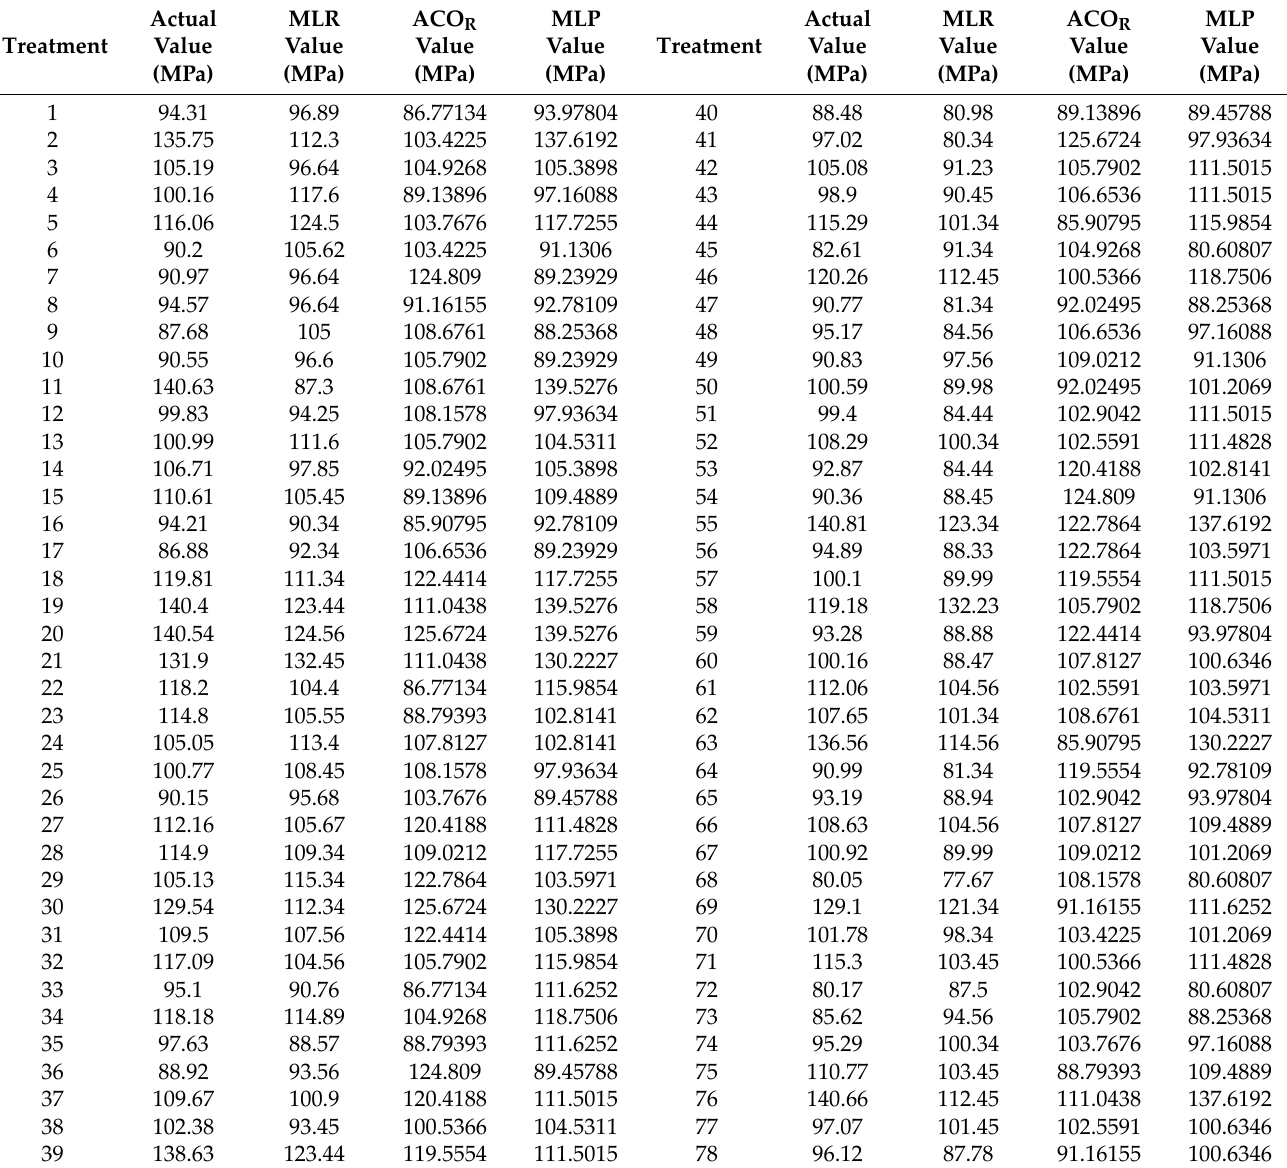
Table 3. The actual values and values estimated by the MLR, ACOR and MLP